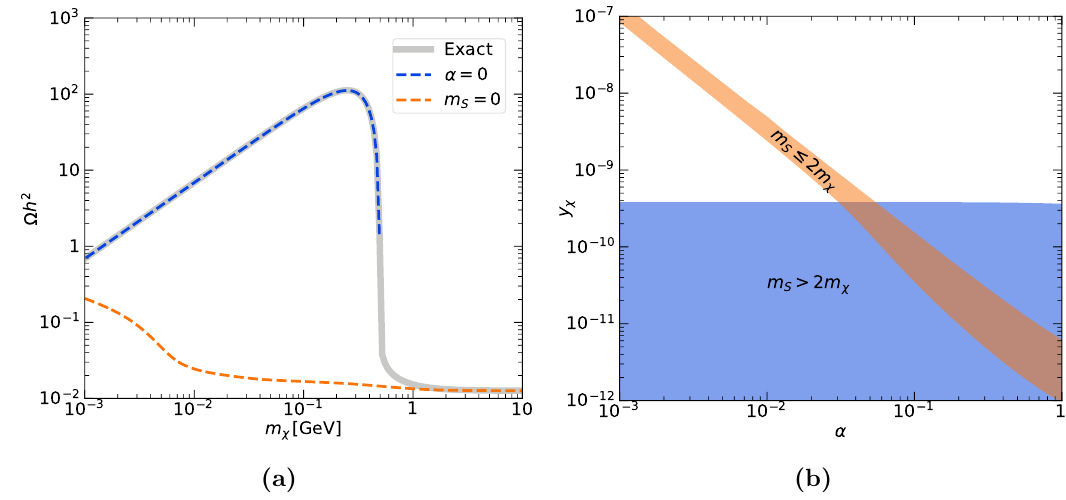
Figure 3. (a) The relic abundance for m is shown in gray, while the other lines correspond to the limits of dominant (blue) and vanishing (orange) m . (b) The area in the plane (cid:11) S